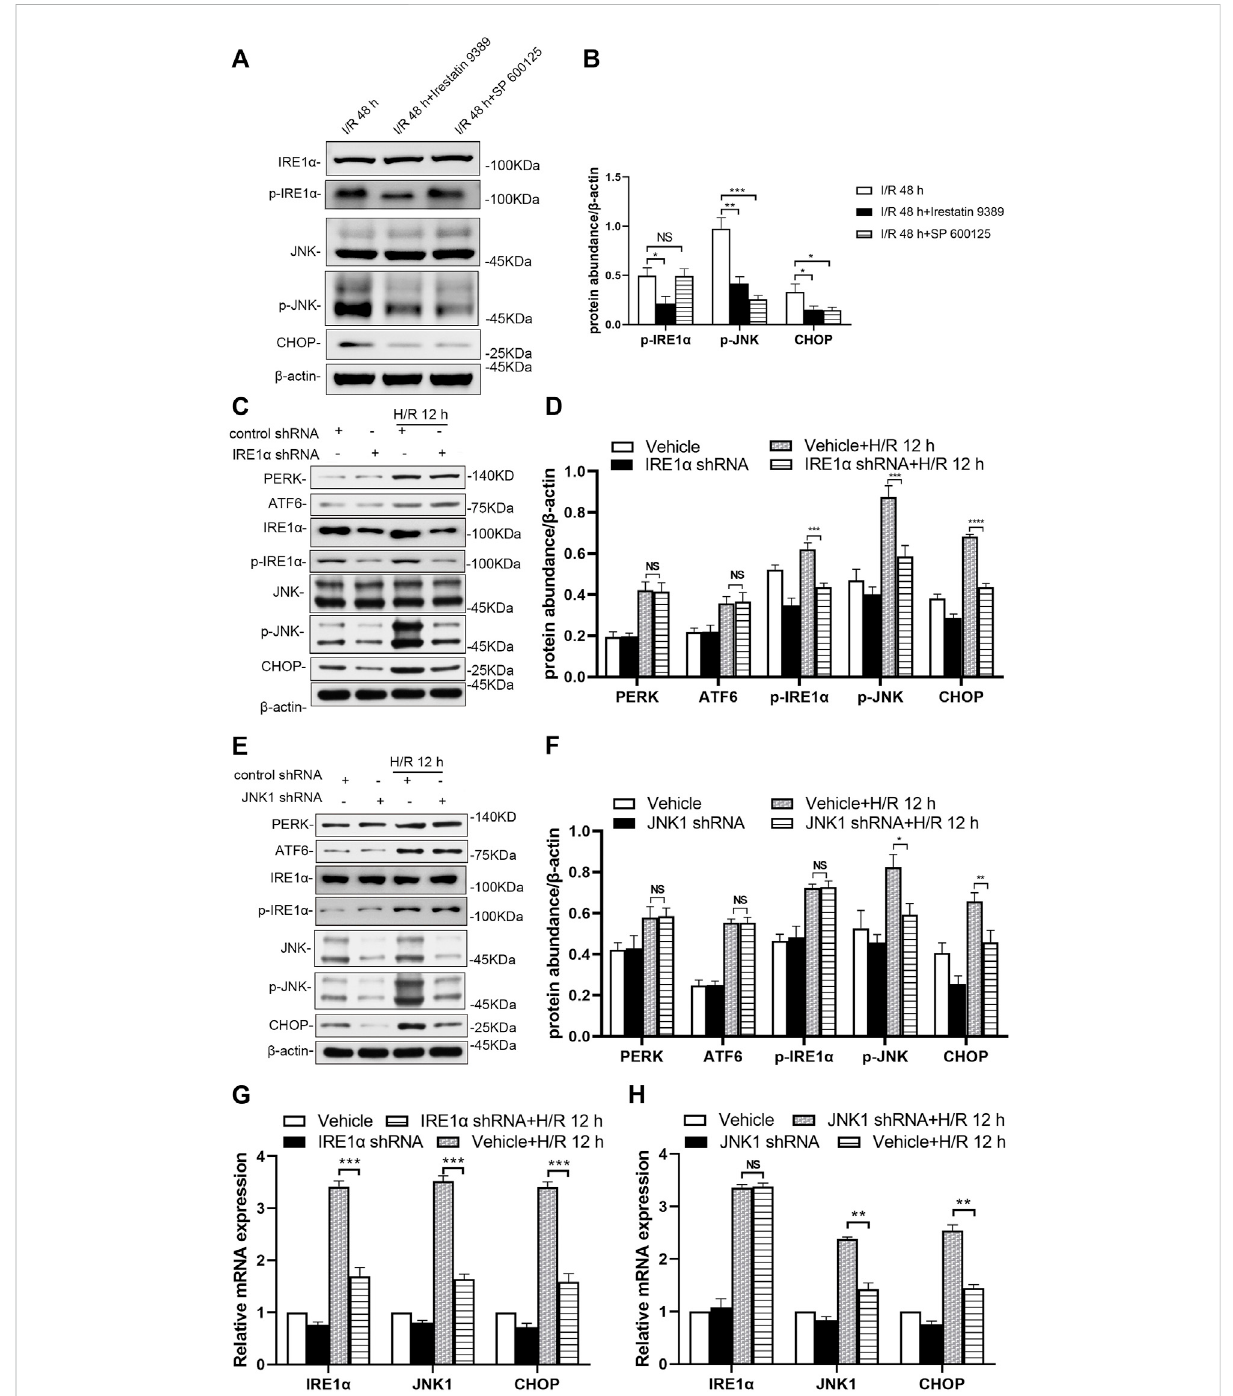
FIGURE 6 DepletionofIRE1orJNKreducesERstressinmiceafterI/RandHK-2cellsafterH/R (A) Comparisonofp-IRE1 α ,p-JNK,andCHOPexpressionin the renal tissue of the I/R, I/R + Irestatin 9389, and I/R + SP 600125 group at 48 h after I/R (B) Protein synthesis of p-IRE1 α , p-JNK, and CHOP in westernblottingintherenaltissue.Duetothedeathofmice,N=5foreachgroup (C) RepresentativewesternblottingofERstressmarkersintheHK- 2 cells depleted of IRE1 α and infected of vehicle at 12 h after H/R, with β -actin used as an internal control (D) Protein synthesis of ER markers in western blotting of the HK-2 cells depleted of IRE1 α (E) Representative western blotting of ER stress markers in the HK-2 cells depleted of JNK1 and infected of vehicle at 12 h after H/R (F) Protein synthesis of ER markers in western blotting of the HK-2 cells depleted of JNK1 (G) mRNA expressions of IRE1 α , JNK1, and CHOP in the HK-2 cells depleted of IRE1 α using qRT-PCR (H) mRNA expressions of IRE1 α , JNK1, and CHOP in the HK-2 cells depleted of JNK1 using qRT-PCR. Statistical signi fi cance is denoted as *: p < 0.05, **: p < 0.01, ***: p < 0.001, ****: p < 0.0001, NS: p > 0.05 in two